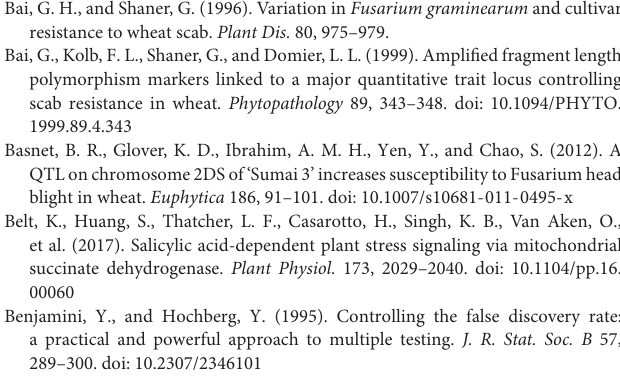
Supplementary Figure 1 | Representation of the sample dispersion from the principal component analysis. For each biological replicate of the cultivar × strain combinations and the control samples, principal component analysis was performed using: (A) the whole set of identified wheat protein quantification values, (B) a subset of protein corresponding to the basal abundance differences between the three wheat cultivars ( Cv_effect and Cv + Cv_effect proteins) and, (C) a subset of protein quantification values reflecting a cultivar-specific response to the disease ( Cv × T_effect proteins) or F. graminearum strain-specific adjustments ( Cv × T{S}_effect proteins). Water-inoculated samples are indicated in light blue, light green and light red for Recital, Cadenza, and Renan cultivars respectively. F. graminearum -inoculated samples were plotted in blue, green and red for Recital, Cadenza, and Renan cultivars respectively. For each Cultivar × Treatment groups, 95% confidence ellipses were plotted using the same color code. Supplementary Figure 2 | rCCA correlation circle plot from the two first components for all wheat cultivar – F. graminearum strain combinations. Blue triangles correspond to the wheat proteins and Red circle to the F. graminearum putative effectors identified in Fabre et al. (2019a). Supplementary Figure 3 | rCCA unit representation plot from the two first components for all wheat cultivar – F. graminearum strain combinations. Supplementary Table 1 | Table summarizing bioinformatics analyses of the identified wheat proteins and F. graminearum putative effectors. Supplementary Table 2 | Functional annotations of the identified wheat proteins using HMMER and PFAM-A database. Supplementary Table 3 | Gene ontology annotations of all identified wheat proteins. Supplementary Table 4 | Summary table indicating the presence/absence analysis of the wheat proteins identified in the different samples. Supplementary Table 5 | Table showing the average of wheat protein abundances quantified in the three biological replicates for each cultivar × F. graminearum strain combination and control samples. Supplementary Table 6 | List of the protein groups described in the Venn diagram. Supplementary Table 7 | Gene ontology enrichment identified in wheat protein clusters. Supplementary Table 8 | Table indicating all canonical correlation scores between wheat and F. graminearum protein pairs. Supplementary Table 9 | Table indicating the potential susceptibility factors identified from literature and corresponding to the wheat proteins identified in this